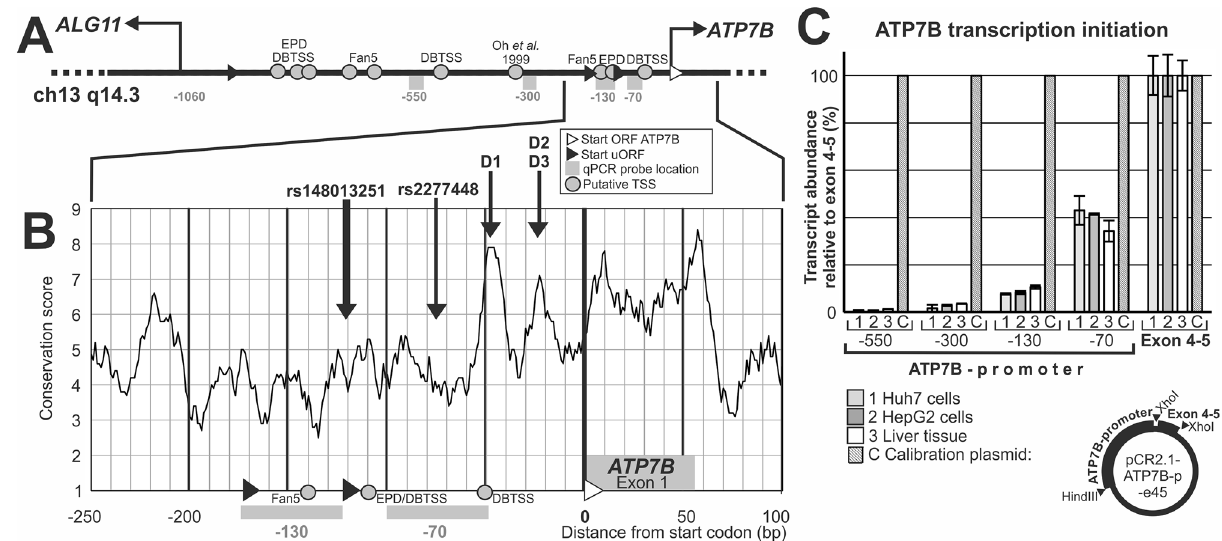
Figure 1. Promoter of ATP7B and transcription initiation. ( A ) Scheme of the bidirectional promoter of the ALG11 and ATP7B genes, which contains several putative transcriptional start sites (grey circles). It also contains three uORFs (black triangles) in direction of ATP7B which are not in frame with the ATP7B translational start site (white triangle). The position of four qPCR probes (− 70; − 130; − 300; − 550) is shown by grey boxes. ( B ) Conservation was scored within the immediate surrounding of the ATP7B translational start site (− 250 to + 100) using ConSeq with appropriate alignments. Two common polymorphisms are indicated, as well the positions of uORFs, putative transcriptional start sites, qPCR probe positions (same symbols as in A.) ( C ) Transcription initiation was tested by quantifying transcript with qPCR probes testing four ATP7B promoter locations (− 70, − 130, − 300 and − 550 bp) in comparison to the coding sequence (Exon 4–5). A calibration plasmid containing both the promoter and Exon 4–5 sequences was used for signal standardization. cDNA from liver cell lines (Huh7, HepG2) and from human liver tissue were tested. DBTSS: Database of Transcriptional Start Sites; EPD: Eukaryotic Promoter Database; Fan5: FANTOM5; uORF: upstream open reading